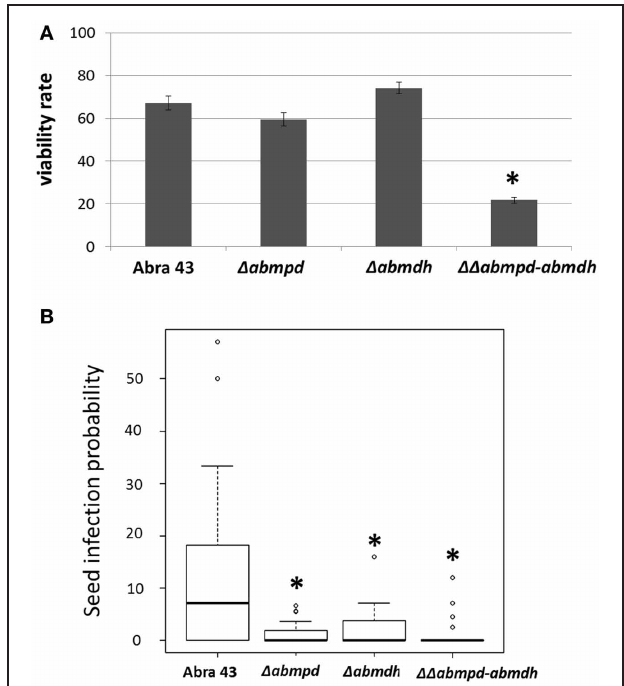
FIGURE 13 | Pathogenic behavior of replacement mutants on reproductive organs. (A) Ability of the fungus to survive after storage on dry seeds. B. oleracea seeds were artificially inoculated by incubation in a conidia suspension of wild-type or mutant strains. The fungal viability rates were estimated by calculating the ratios between the nephelometric lag times obtained from seed batches before and after 6-months of storage. Ten seeds were analyzed for each fungal genotype and the experiment was repeated twice. Error bars indicate standard deviations. Asterisks indicate a significant difference between the mutant and the parental isolate (Student test, P < 0 . 01). (B) Influence of mannitol metabolism on the transmission capacity of A. brassicicola to A. thaliana seeds (L er ecotype). The seed infection probability was evaluated as described by Pochon et al. (2012). The five youngest siliques of at least five plants were inoculated with each fungal genotype and the experiment was repeated twice. Contaminated siliques were harvested 10dpi. After dissection, seeds were incubated separately on PDA medium for 2 days. A seed was considered as contaminated when incubation resulted in typical A. brassicicola colony development. For each inoculated fungal genotype, the seed infection probability was evaluated from at least 1000 seeds. Asterisks indicate a significant difference between the mutant and the parental isolate (Student test, P < 0 .